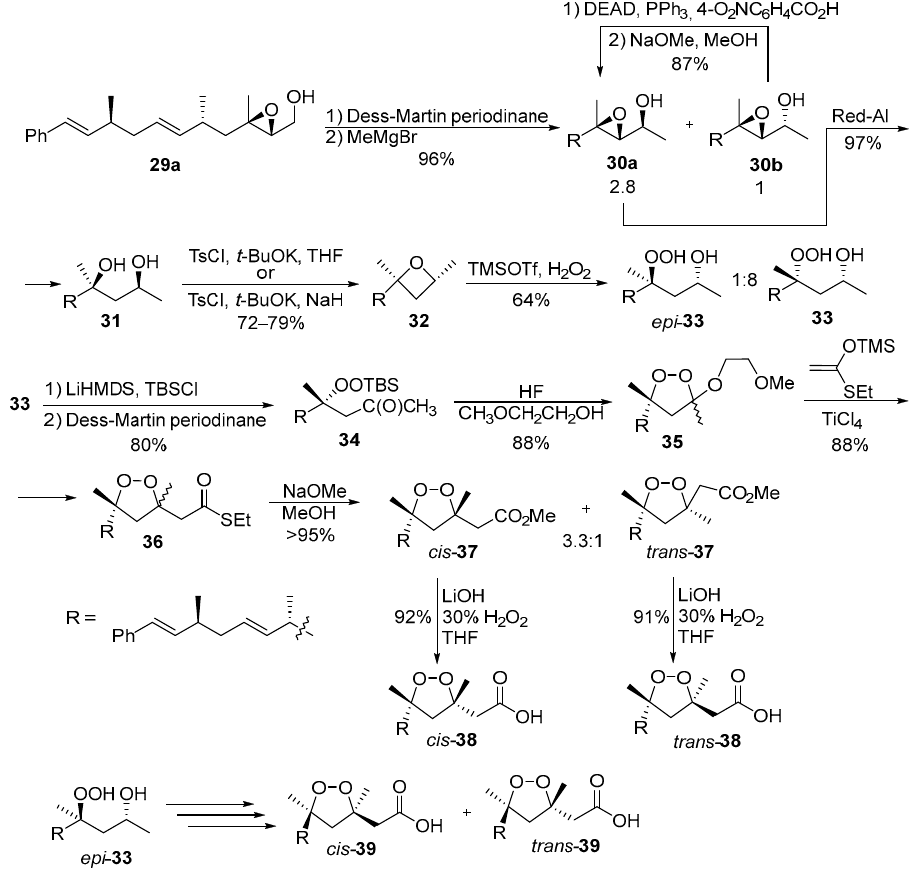
Scheme 5. Asymmetric synthesis of plakinic acids 38 and 39 .